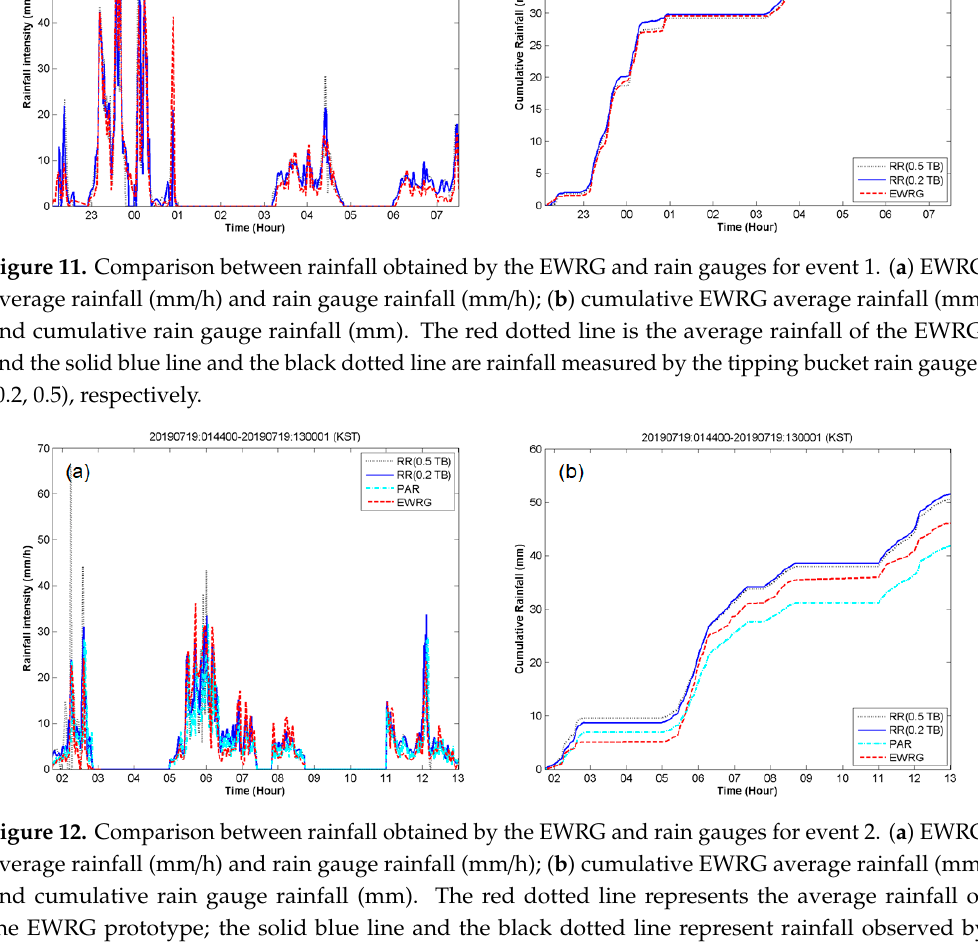
Figure 13. Comparison between rainfall obtained by the EWRG and rain gauges for event 3. ( a ) EWRG average rainfall (mm/h) and rain gauge rainfall (mm/h); ( b ) cumulative EWRG average rainfall (mm) and cumulative rain gauge rainfall (mm). The red dotted line represents the average rainfall of the EWRG prototype; the solid blue line and the black dotted line represent rainfall observed by the tipping bucket rain gauges (0.2, 0.5), and the light blue dashed line represents rainfall from the Parsivel disdrometer. 4.2. EWRG Field Test (Yeoncheon) To evaluate the EWRG’s performance, a testbed was established at the Yeoncheon SOC Demonstration Research Center of the Korea Institute of Civil Engineering and Building Technology. In addition to using a typical tipping bucket rain gauge and Parsivel disdrometer, a pit-gauge was installed to obtain more accurate ground rainfall observations at the site. The layout of the comparison testbed (complex pit-gauge and EWRG) established in the Yeoncheon SOC Demonstration Research Center is depicted in Figure 14.